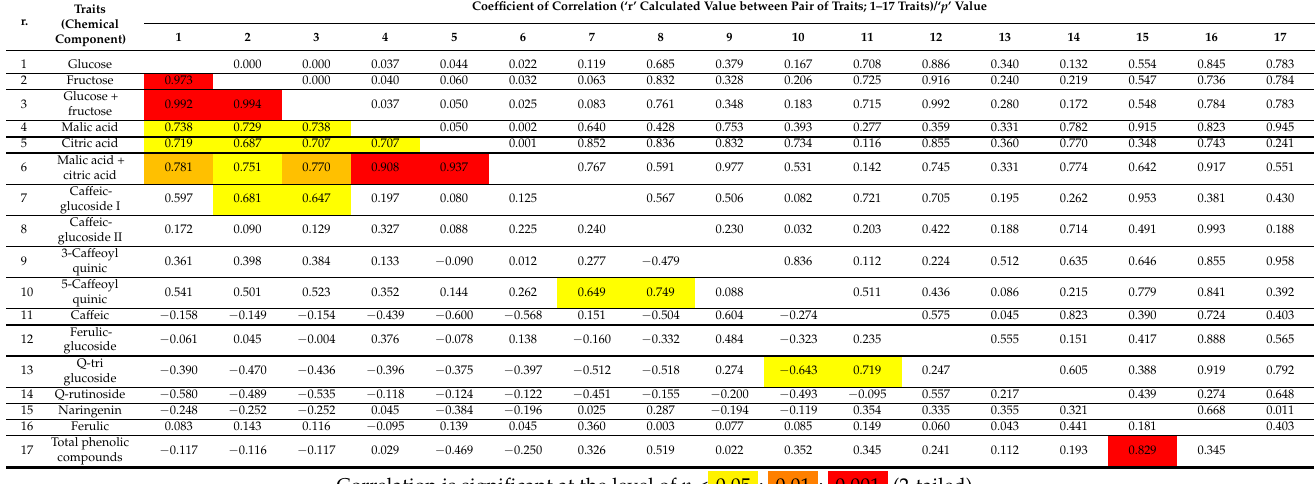
Table 3. Phenotypic correlations between the pairs of characteristics analyzed (below the diagonal) and p value of the correlation (above the diagonal).